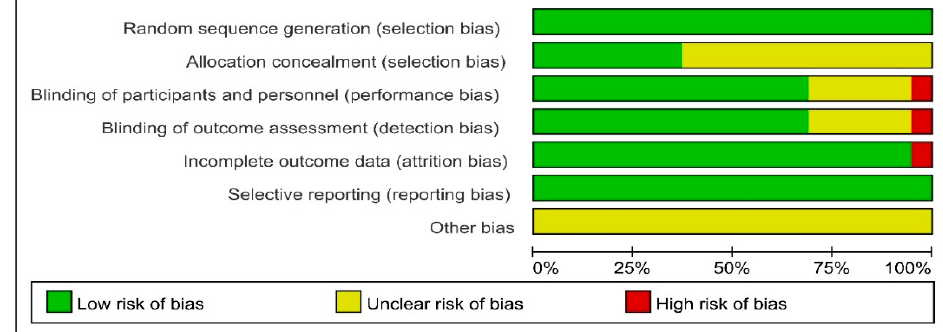
Figure 3. Punctuation of risk of bias tool [12,18–23,36,45–55]. 3.2. Results of Meta-Analysis According to the results of the heterogeneity assessment, the random effects model meta-analysis was conducted to analyze the efficacy of Pilates in the context of the Pain Scale, ODI, and RMDQ of CLBP patients. The results showed that there were statistically significant differences between trial groups and control groups, which indicated that Pi- lates has a positive improvement on Pain Scale [SMD = − 1.31, 95%CI ( − 1.80, − 0.83), p < 0.00001], ODI [MD = − 4.35, 95%CI( − 5.77, − 2.94), p < 0.00001], and RMDQ [MD = − 2.26, 95%CI ( − 4.45, − 0.08), p = 0.04] in CLBP patients. The results of the meta-analysis are pre- sented in Figures 4–6. Four of the included RCTs [45,46,48,53] reported the effect of Pilates on four dimen- sions of SF-36, including Physical Function (PF), Role Physical (RP), Bodily Pain (BP), and General Health (GH), in the CLBP patients. The fixed effects model and random effects model were, respectively, used in the meta-analysis. The results showed the following: PF in trial groups was significantly different from control groups [MD = 5.09, 95%CI (0.20, 9.99), p = 0.04], and there was no statistically significant difference in RP [MD = 5.02, 95%CI ( − 1.03, 11.06), p = 0.10], BP [MD = 8.79, 95%CI ( − 1.57, 19.16), p = 0.10], and GH [MD = 8.45, 95%CI ( − 5.61, 22.51), p = 0.24] between trial groups and the controls. These results indi- cated that Pilates could positively improve SF-36-PF but not RP, BP, and GH in CLBP